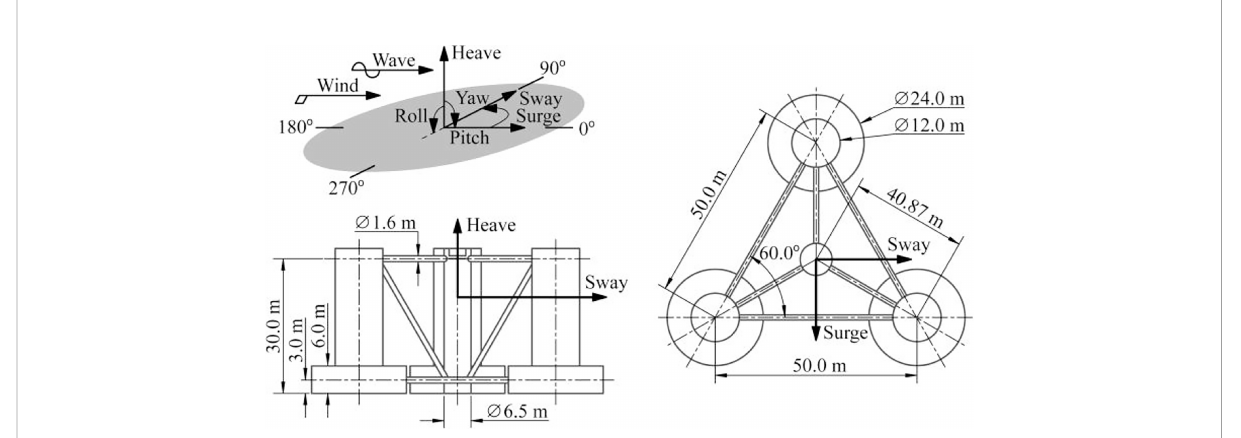
FIGURE 5 Dimensions and coordinate system of the DeepCwind semi-submersible support platform (Coulling et al.,